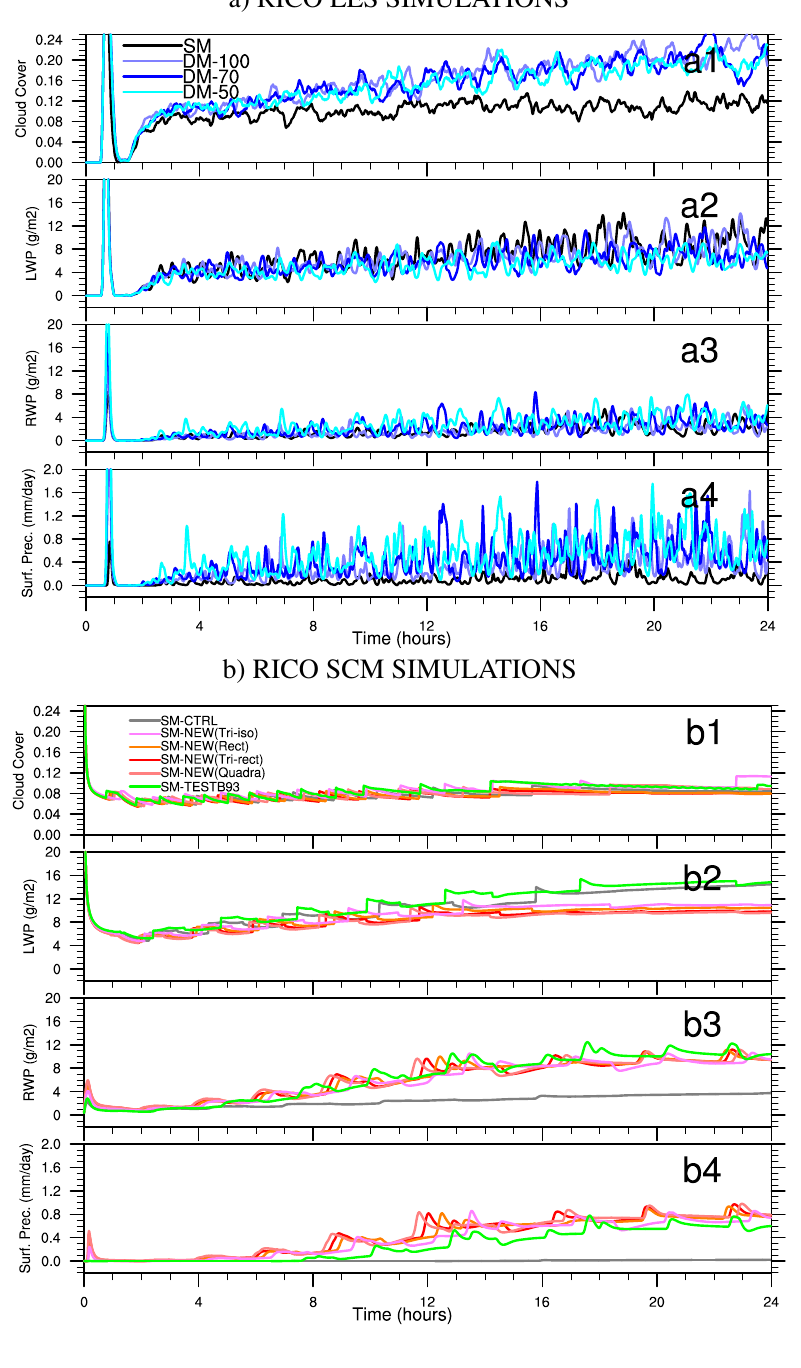
Fig. 10. Same as Fig. 5 for